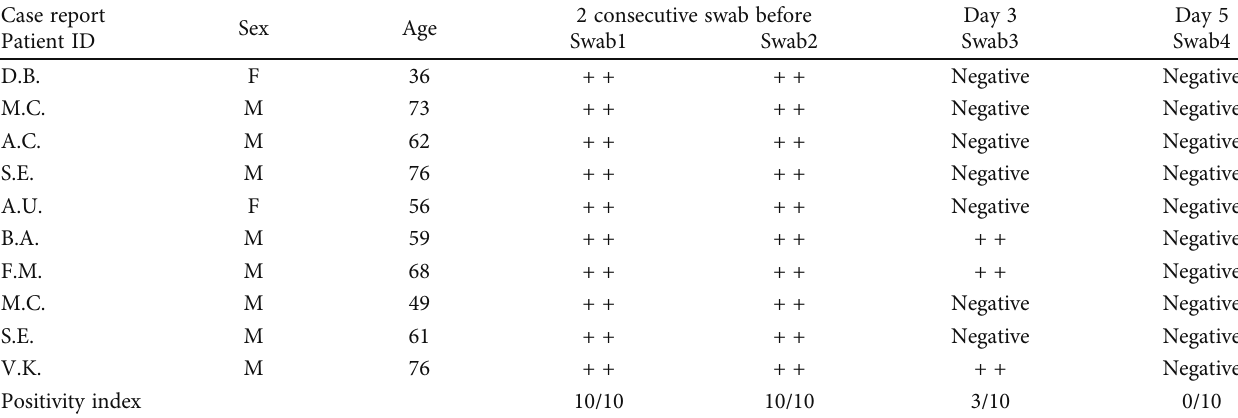
Table 6: Case report of 10 healthy voluntaries, carriers of SARS-CoV-2, treated with our